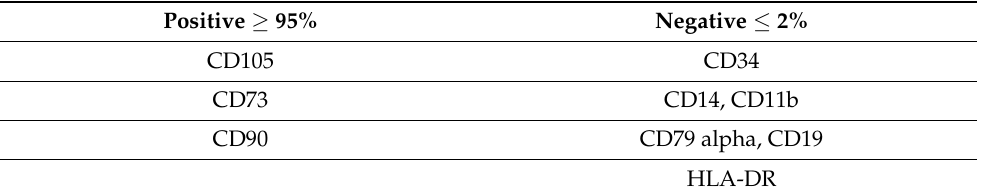
Table 2. Phenotype of mesenchymal stem cells.